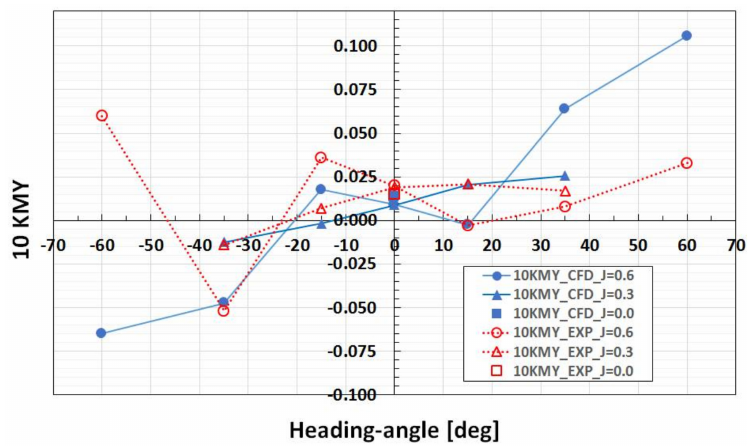
Figure 11. Measured (red) and computed (blue) steering moment, KMY, excluding duct contribution, at different heading angles and loading conditions.